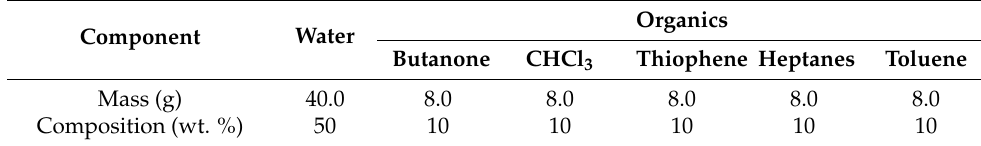
Table 5. Initial composition of each component in the feed. Organics Component Water Butanone CHCl 3 Thiophene Heptanes Toluene Mass (g) 40.0 8.0 8.0 8.0 8.0 8.0 Composition (wt. %) 50 10